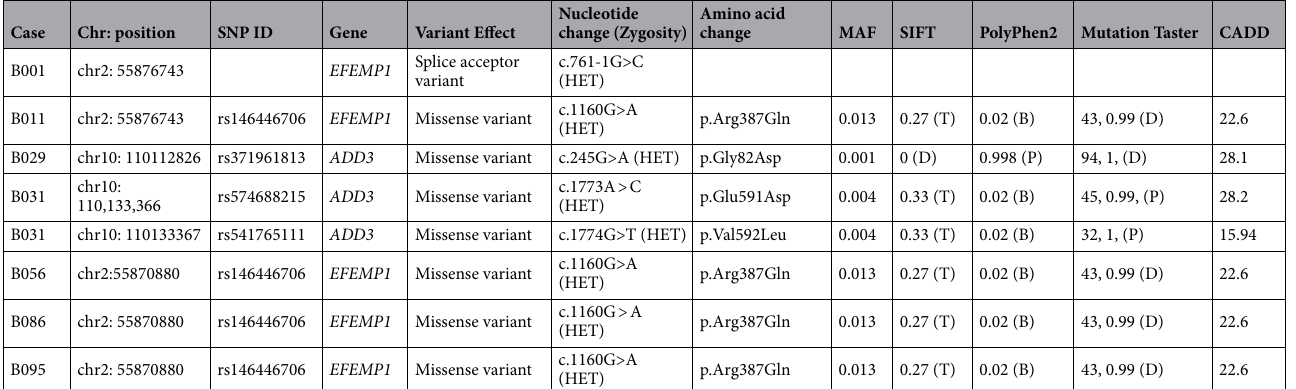
Table 5. Rare variants in the ADD3 and EFEMP1 genes identified by whole exome studies. Chr chromosome, SNP single nucleotide polymorphism, MAF minor allele frequency in East Asian populations, SIFT scale- invariant feature transform ( T tolerated, D damaging), PolyPhen Polymorphism Phenotyping data collection ( B benign, P possibly deleterious, D deleterious), Mutation Taster, Mutation Taster–AA change score and probability value ( D disease causing, P polymorphism), CADD Combined Annotation Dependent Depletion recorded in Phred score, HET heterozygous, HOM